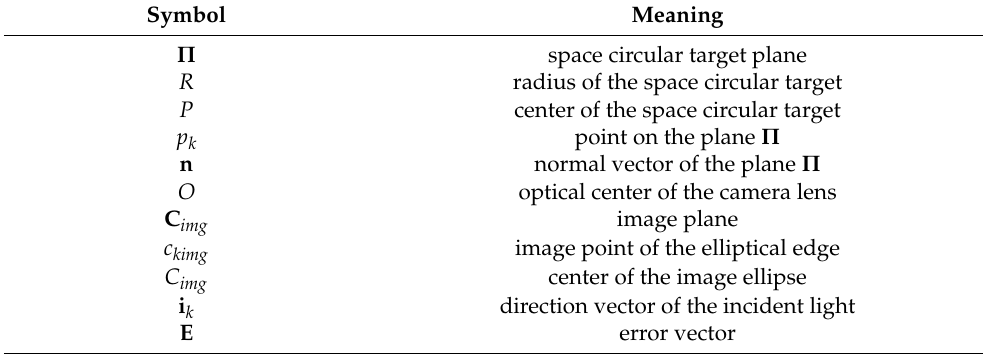
Table 1. Summary of